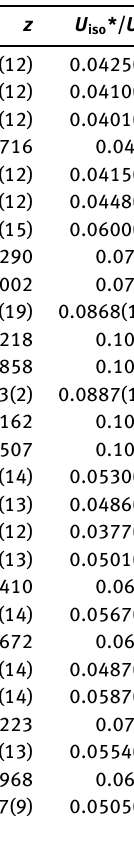
Table 2: Fractional atomic coordinates and isotropic or equivalent isotropic displacement parameters (Å 2